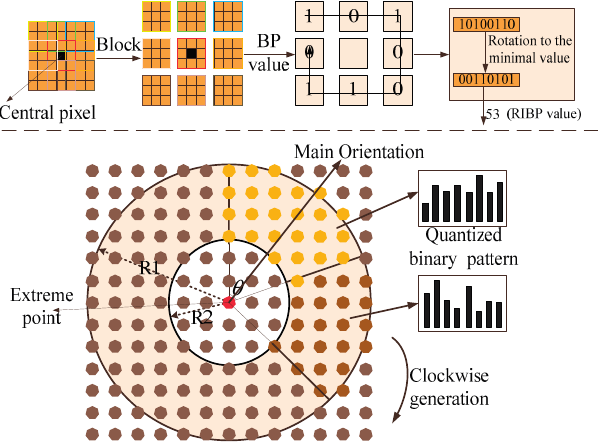
Figure 2. Illustration of the rotation invariant binary pattern based feature computing to achieve fast and robust traffic sign